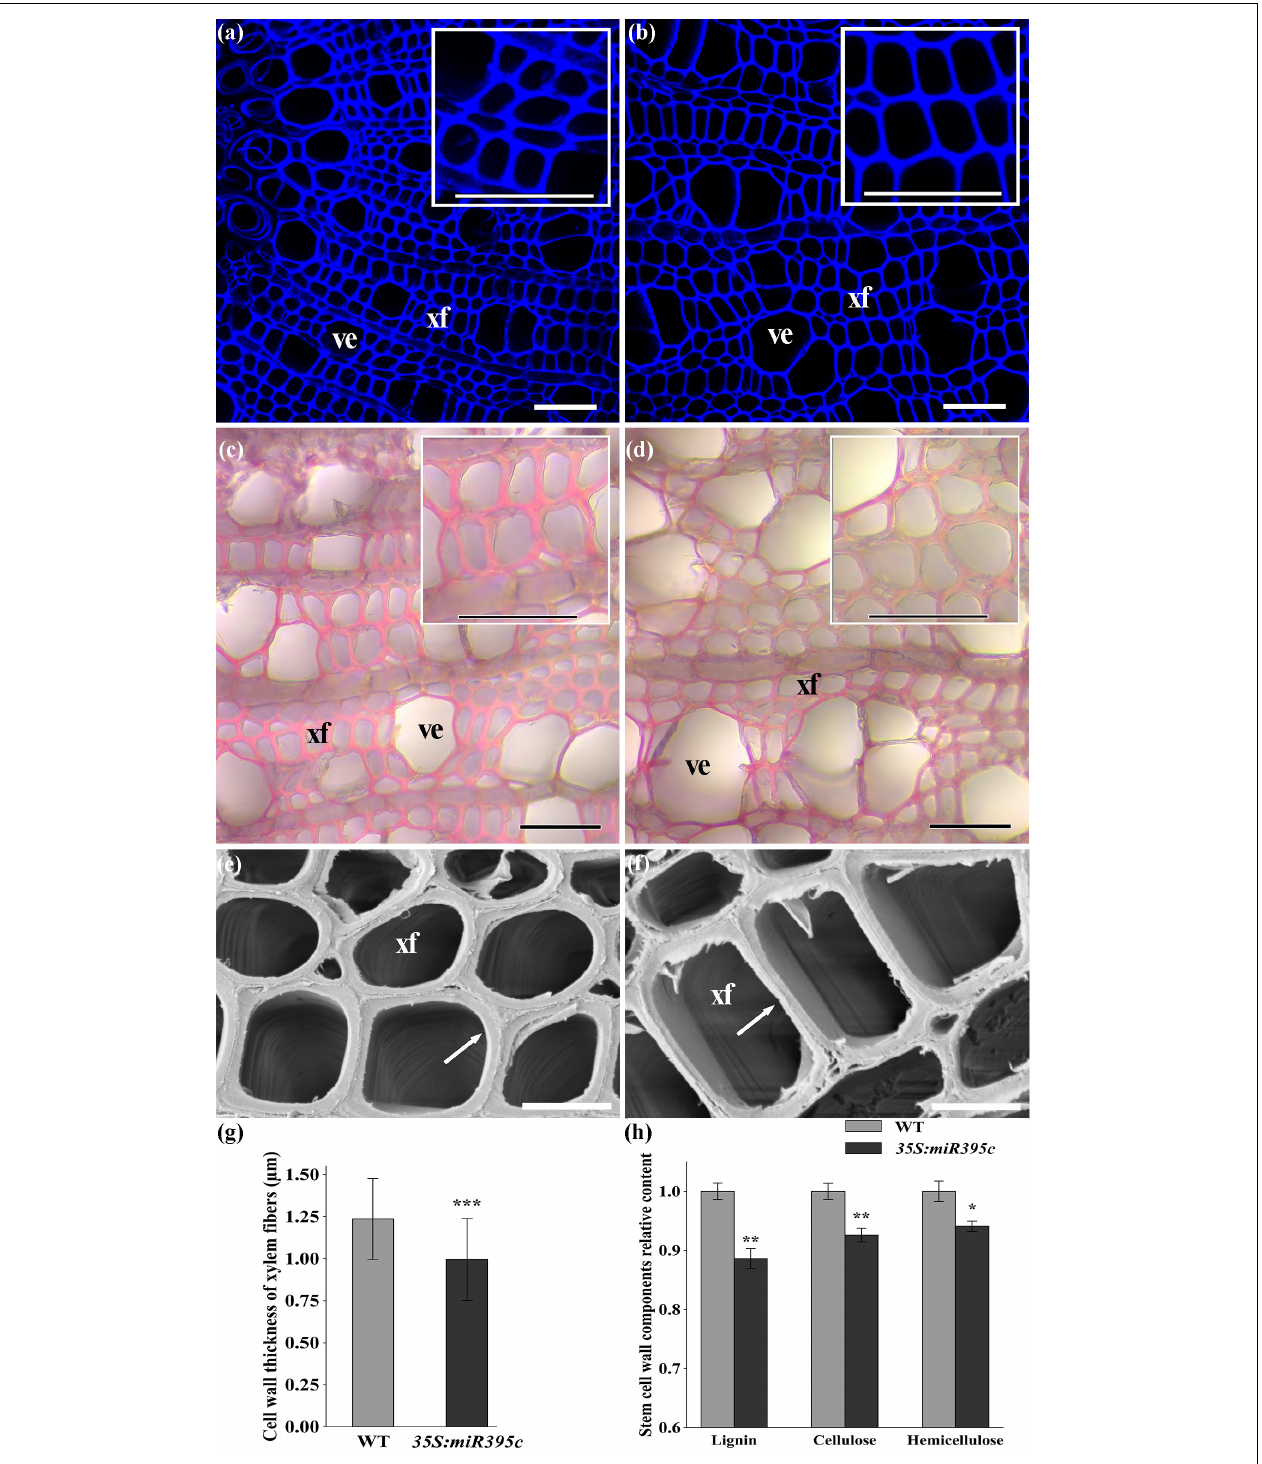
FIGURE 4 | The SCW of the 8th internode of 3-month-old wild type and transgenic poplar. (a) Lignin autofluorescence of wild type. (b) Lignin autofluorescence of miR395c-OE poplar. Phloroglucinol-HCL staining of (c) wild-type and (d) miR395c-OE poplar. Bar, 50 µ m. (e) Electron microscopy on the xylem in wild type. (f) Electron microscopy on the xylem in miR395c-OE poplar. The arrow refers to the wall thickness of the xylem fiber. Bar, 10 µ m. xf, xylem fiber; ve, vessel. (g) The thickness of fiber cell wall decreased in miR395c-OE poplar. (h) The content of lignin, cellulose, and hemicellulose decreased in miR395c-OE poplar. Insets in (a–d) are high-magnification images of the middle xylem area. Asterisks indicate significant difference between transgenic and WT plants using the Student’s t -test, * p < 0.05; ** p < 0.01; *** p < 0.001.